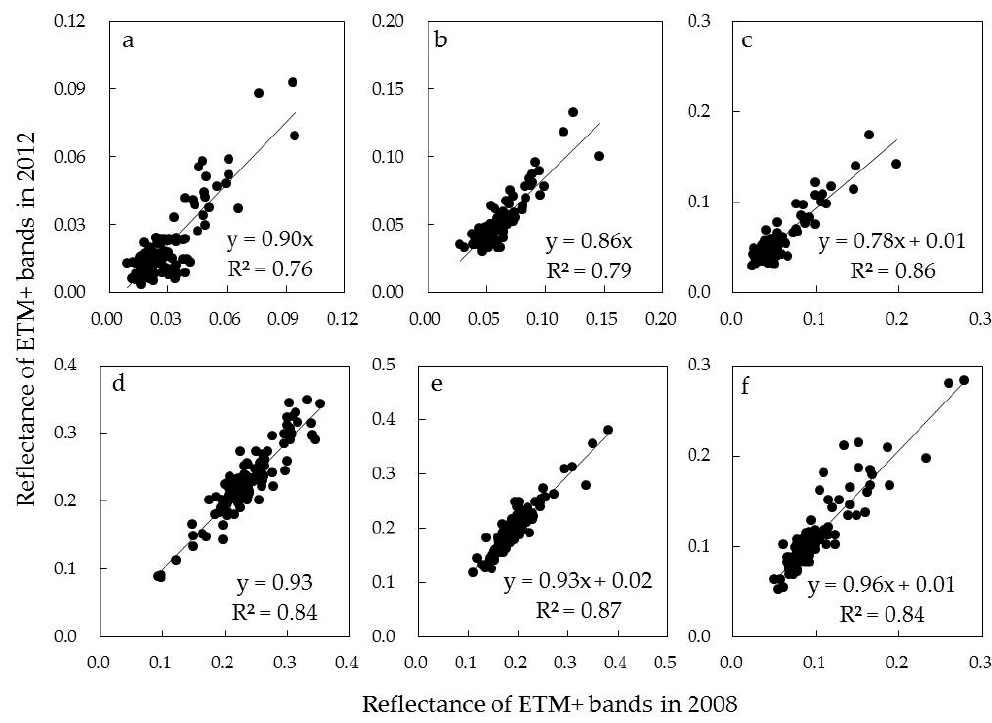
Figure 8. The comparisons between the reflectance values of the PIFs objects for band 1 ( a ), band 2 ( b ), band 3 ( c ), band 4 ( d ), band 5 ( e ) and band 6 ( f ) of Landsat ETM+ images in 2008 and 2012.